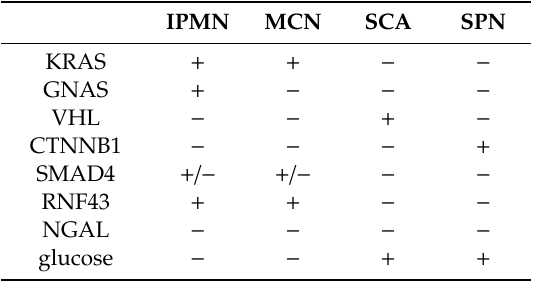
Table 2. Genetic mutation profile of mucinous and non-mucinous cyst subtypes [34,36,37]. IPMN